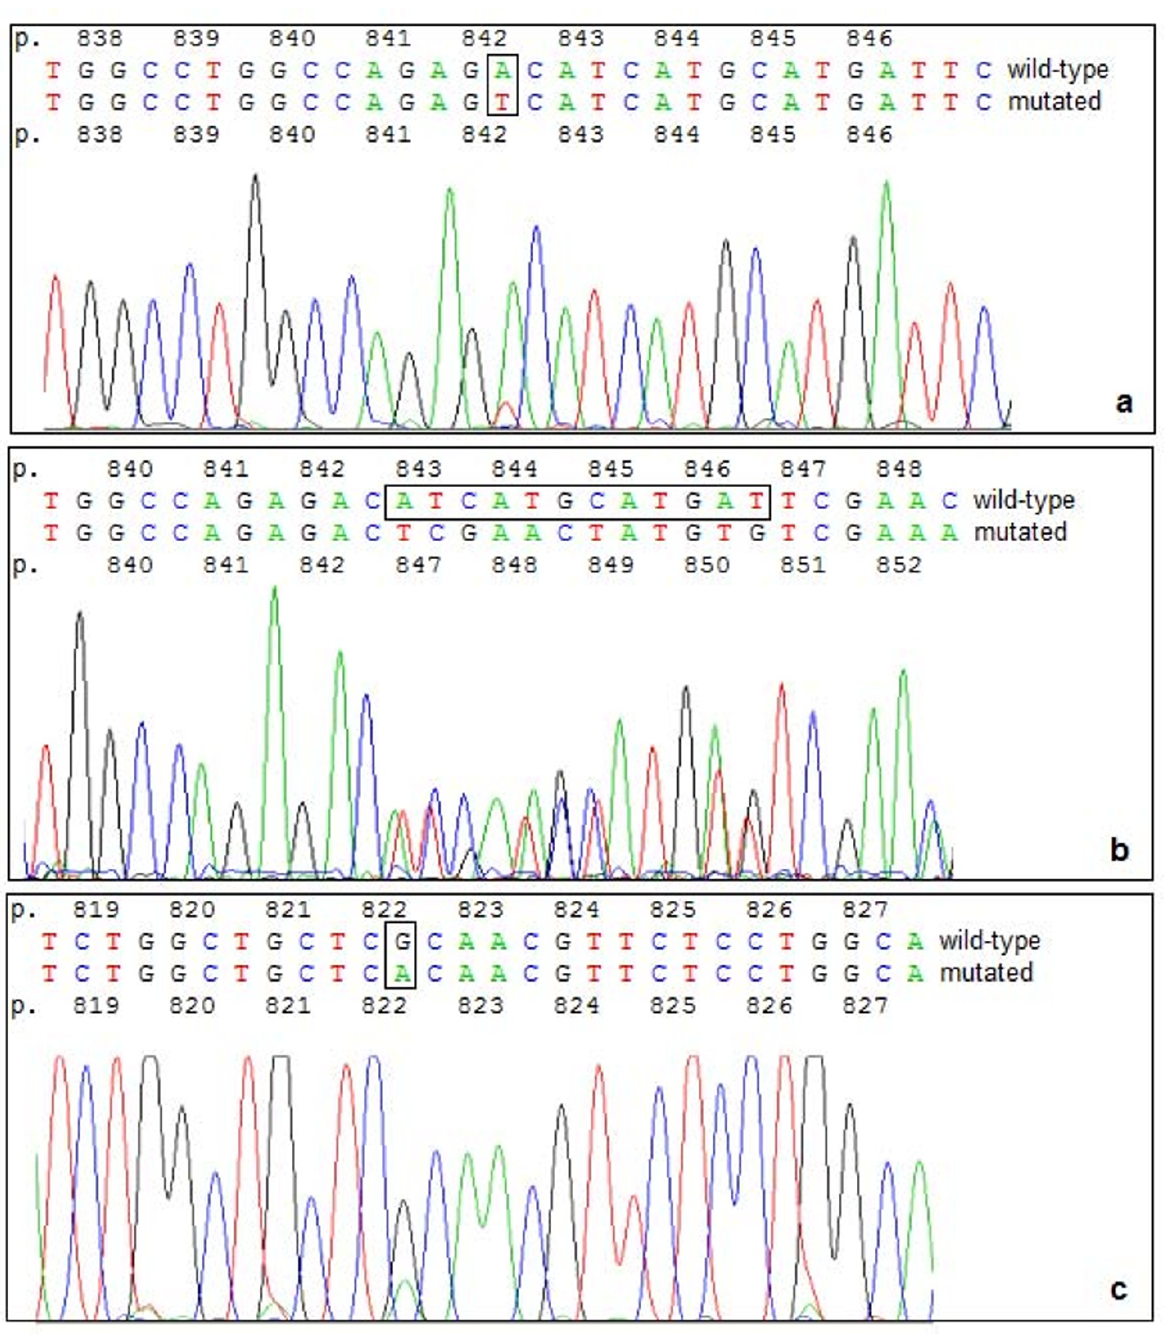
Figure 1 Sequence details illustrating the divergent results of the first trial . a Detail of the forward sequencing reaction of sample T1.6: the mis- sense mutation c.2525A>T leading to p.D842V in PDGFRA was not detected due to high background peaks. b Detail of the forward reaction of sample T1.4: the deletion c.2527_2538del12 in PDGFRA was misinterpreted as p.D842_H845del instead of p.I843_D846del. c Detail of the forward reaction of sample T1.4: Reamplificaton lead to the assumption of an unknown missense mutation in PDGFRA (c.2464G>A leading to p.R822H). Mutated nucle- otides are marked by open